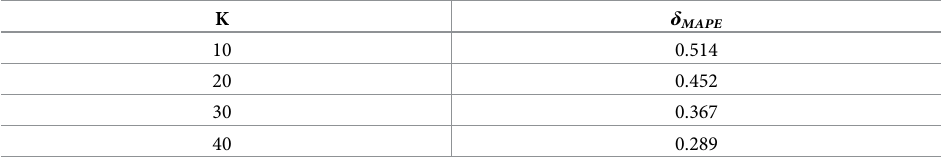
Table 4. A table of mean absolute percentage errors (MAPE) over increasing validation folds of the DEEP journal dataset. MAPE drops with successive increments of validation